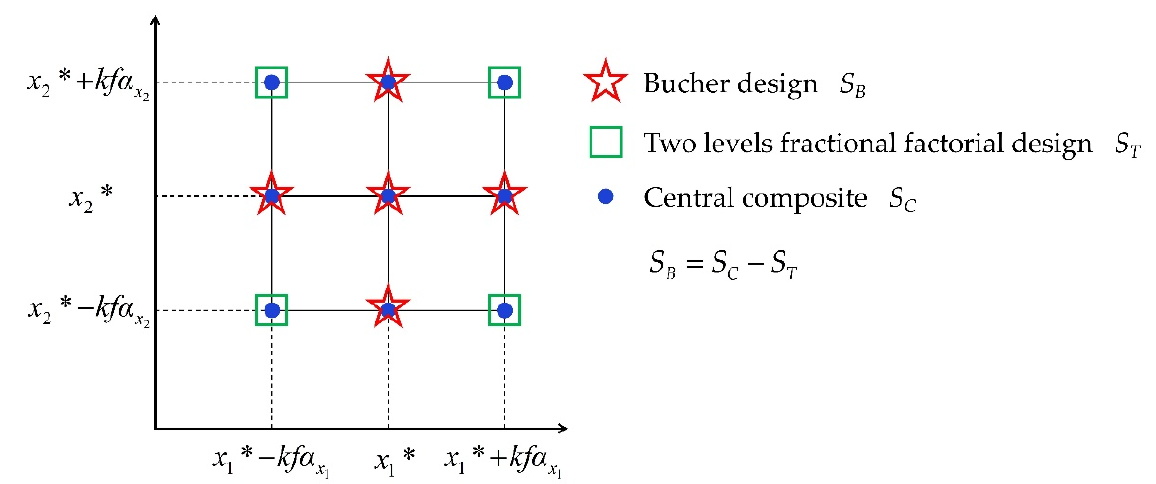
Figure 3. Two-dimensional schematic of the Bucher design.